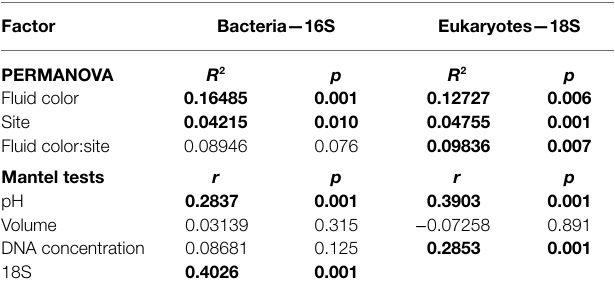
TABLE 2 | Factors affecting bacterial and eukaryotic turnover in community composition.